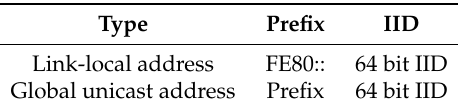
Table 2. Two types of IPv6